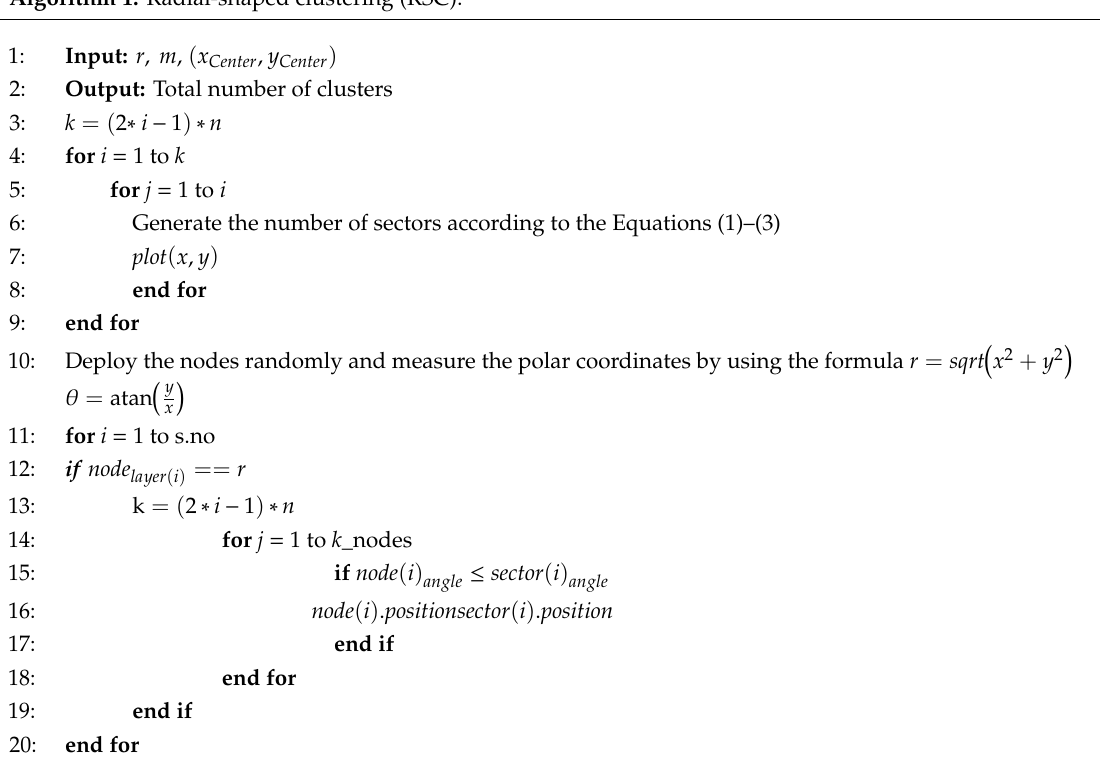
Algorithm 1. Radial-shaped clustering